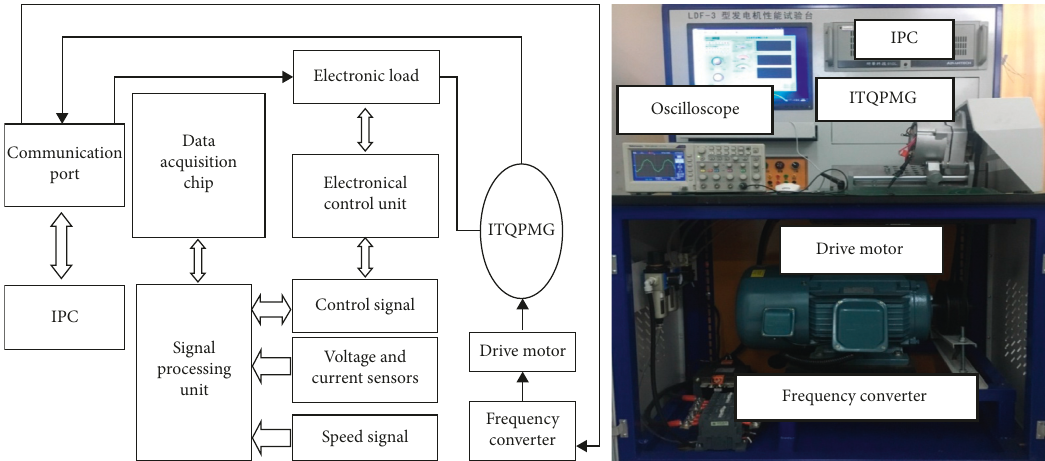
Communication port